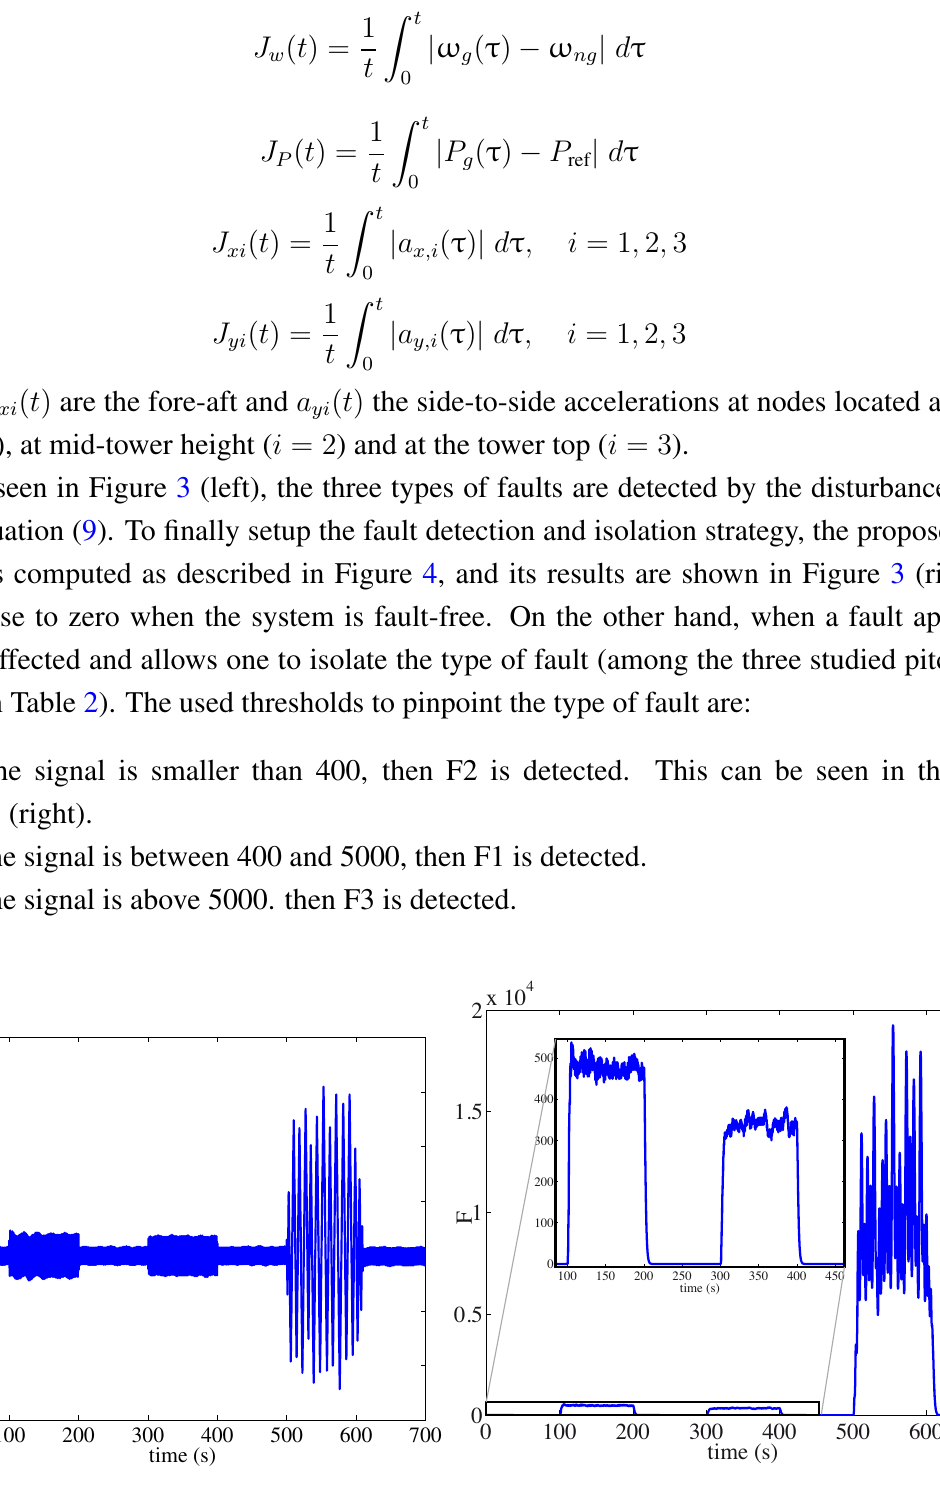
Figure 3. Discrete disturbance estimator ( left ) and the continuous residual signal ( right